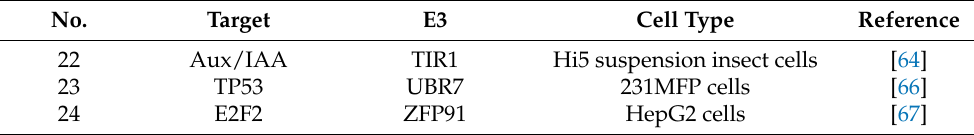
Table 12. Natural product targets 22–24.